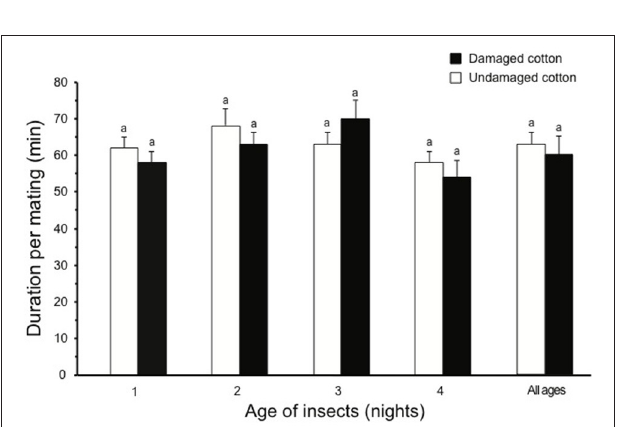
FIGURE 7 | Duration per mating in S. littoralis when allowed to mate in the presence of damaged (black bars) and undamaged (white bars) cotton plants, separately. Standard errors are represented on each bar. Chi square test was used for statistical analysis. Different letters within bars of each age show significant effect ( P < 0.05, or 0.01or